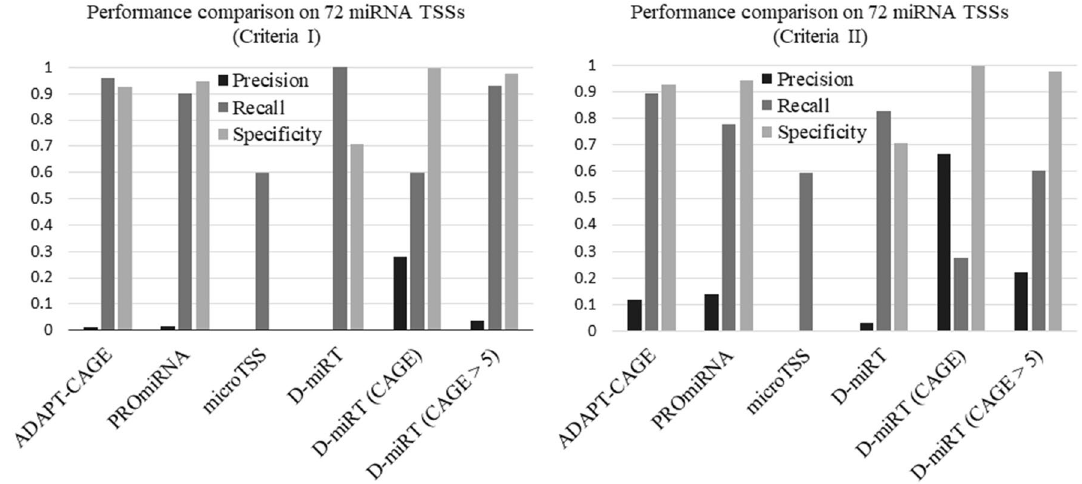
Figure 3. Performance comparison of ADAPT-CAGE, PROmiRNA, microTSS, D-miRT and the two versions of D-miRT with CAGE filtering on their predictions of 72 miRNA TSSs with ± 50 bp neighborhood. Here the performances were shown using two definition criteria of the